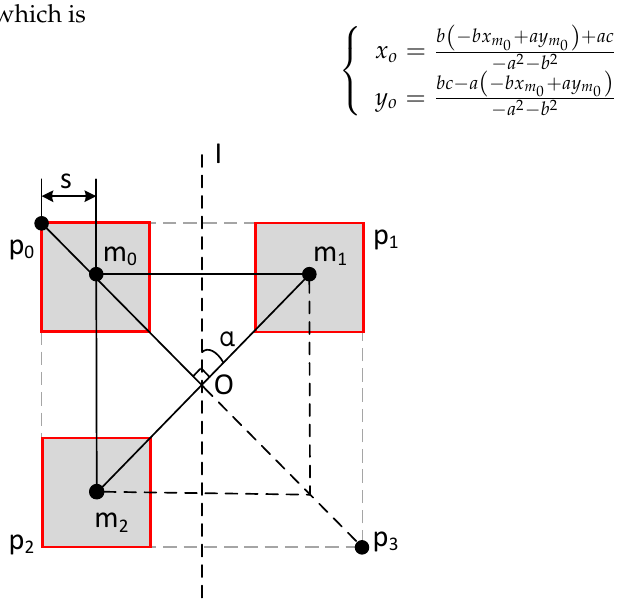
: ax + by + c = 0. The projection point O of 1 m 2 establishes the center of the QR code, 1 m 2